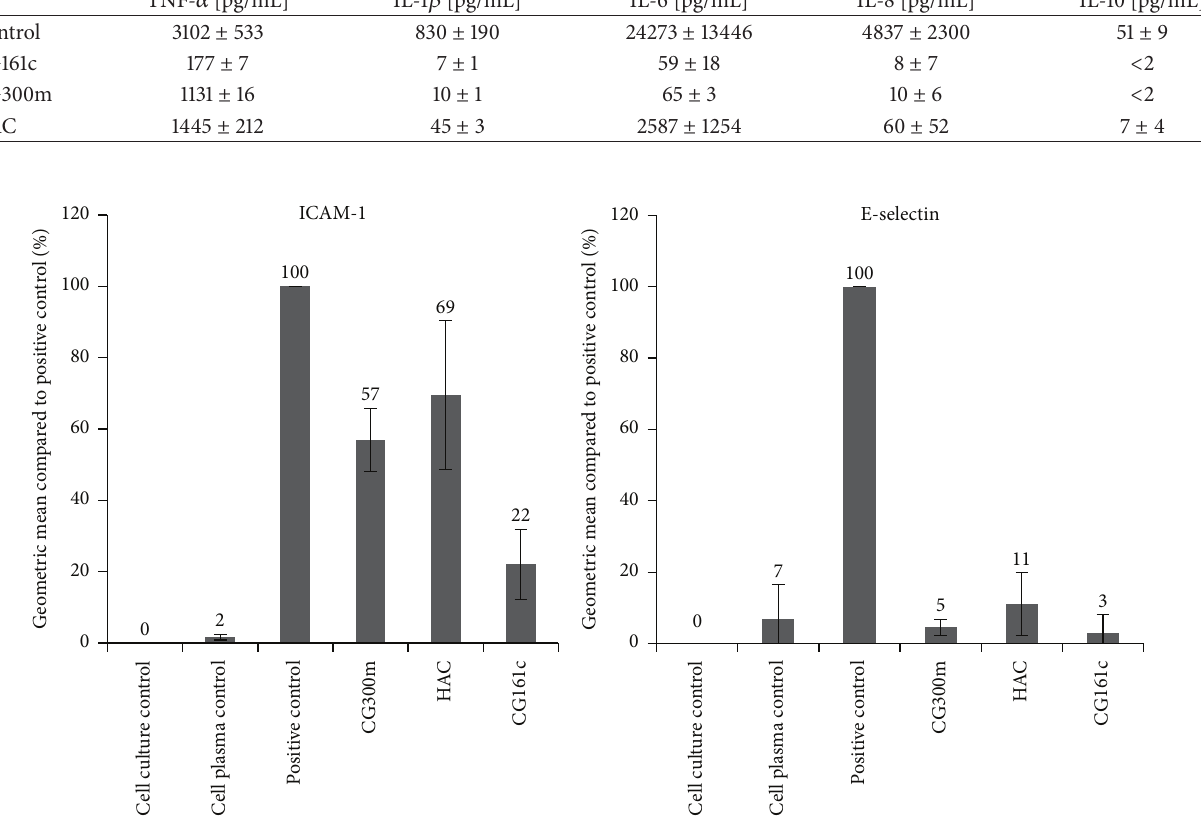
Figure 4: ICAM-1 and E-selectin expression by HUVEC. The effect of cytokine removal on endothelial cell activation was assessed by measuring the expressed adhesion molecules ICAM-1 and E-selectin after incubation of HUVECs with 10% of sample plasma from the adsorption experiments. The results are shown in mean ± SD.